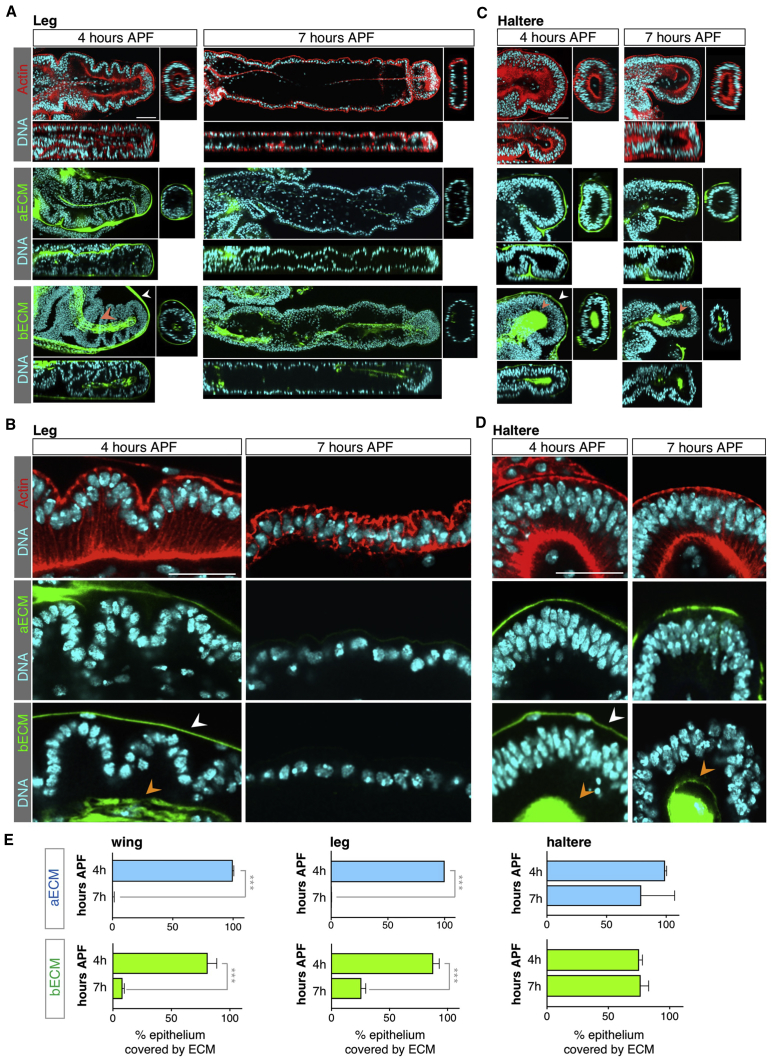
Remodeling of the Extracellular Matrix Also Occurs in the Leg, but Not the Haltere(A) Drosophila leg cross-sections at 4 hr APF, before peripodial membrane release, and 7 hr APF, after anisotropic expansion and tissue flattening. As in the developing wing, elongation of the leg involves degradation of apical Dp-YFP and basal Vkg-GFP in contact with the leg epithelial cells (orange arrowhead) just prior to tissue elongation, which proceeds by columnar-to-cuboidal cell shape change. At 4 hr APF a layer of basal Vkg-GFP covers the basal surface of the peripodial membrane cells (white arrowhead). Scale bar, 50 μm.(B) High-magnification view of epithelial cells of the leg disc at 4 hr APF, in contact with apical Dp-YFP and basal Vkg-GFP (orange arrow), and at 7 hr APF, when the matrix is removed and cells adopt a cuboidal-like morphology. At 4 hr APF epithelial cells are columnar and all reach the basal surface, as shown by the actin cytoskeleton (red), and a layer of basal Vkg-GFP covers the basal surface of the peripodial membrane cells (white arrowhead). Scale bar, 25 μm.(C) Developing haltere cross-sections at 4 hr APF, before peripodial membrane release, and 7 hr APF, after peripodial membrane release. In contrast with wing and leg development, the haltere disc does not extend from 4 to 7 hr APF, and apical Dp-YFP and basal Vkg-GFP (orange arrowhead) cover the haltere epithelia during the entire process. The ECM remains present at both the apical and basal surface of the haltere throughout this process, despite the removal of the overlying peripodial layer. The layer of basal Vkg-GFP that covers the basal surface is only detectable at 4 hr APF (white arrowhead). Scale bar, 50 μm.(D) High-magnification cross-section of pseudo-stratified columnar haltere epithelia at 4 and 7 hr APF in contact with apical Dp-YFP and basal Vkg-GFP (orange arrowheads). At 4 hr APF Vkg-GFP also covers the basal surface of the peripodial membrane (white arrowhead). Scale bar, 25 μm.(E) Quantification of the percentage of epithelium covered with apical Dp-YFP and basal Vkg-GFP in control wings, legs, and halteres at 4 and 7 hr APF. Average, SD, and individual data points are presented; n > 4 for each developmental stage. Statistically significant differences are indicated (∗∗∗p < 0.001).